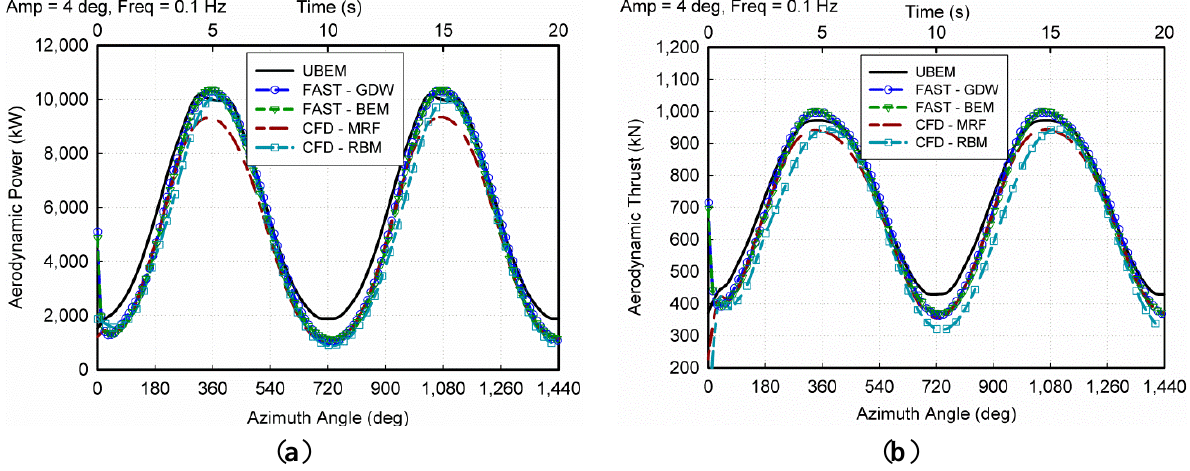
Figure 8. Unsteady aerodynamic comparison using the UBEM, CFD and FAST (NREL) methods for a platform pitching motion with an amplitude of 4° and a frequency of 0.1 Hz. ( a ) Aerodynamic Power; ( b ) Aerodynamic